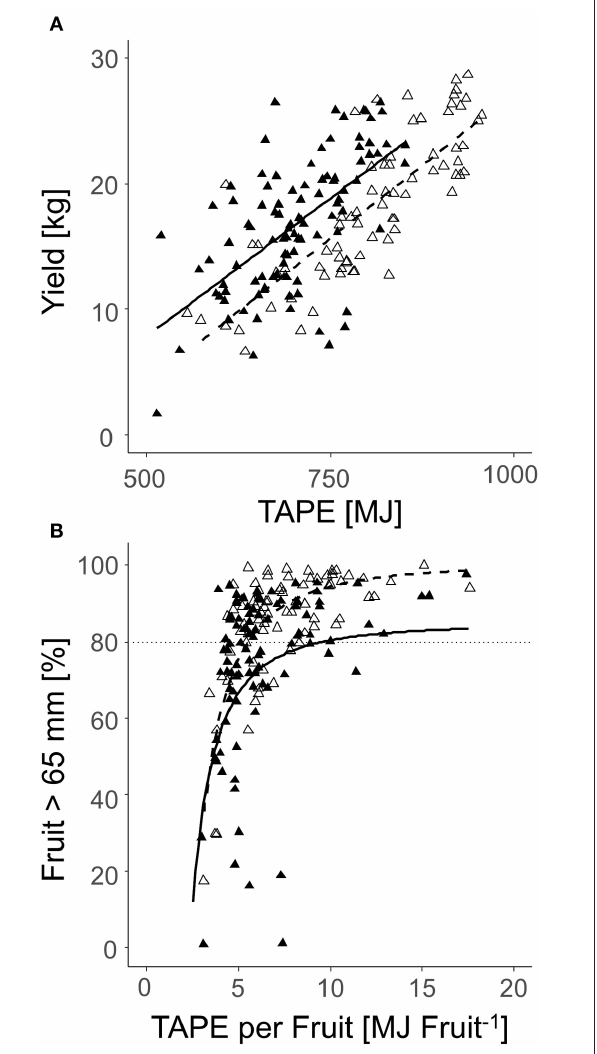
FIGURE 11 | Relationships between the soluble solids content [SSC (%)] and the total absorbed photosynthetic energy (TAPE)* per fruit (A) ; SD and mean SSC (B) ; the percentage of fruit with SSC > 12% per tree according to TAPE per fruit (C) of ‘Gala’ fruit from each individual tree ( n = 9) in 2018 [closed triangle, solid line; (A) R ² = 0.16; (C) ns] and 2019 [open triangle, dashed line; (A) R ² = 0.23; (C) R ² = 0.73] (2018: 80–127 DAFB; 2019: 84–138 DAFB).